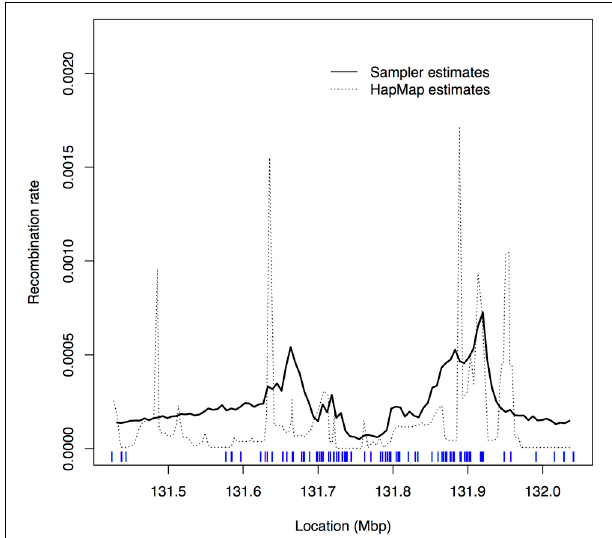
FIGURE 2 | Plot of recombination rate values, ρ , estimated by sampletrees and by HapMap. Solid curve: average of the sampled ρ values from sampletrees for each focal point; Dashed curve: rescaled recombination rates estimated from Phase I HapMap data (release 16a) (International HapMap Consortium, 2005). The tickmarks at the bottom show the marker locations.